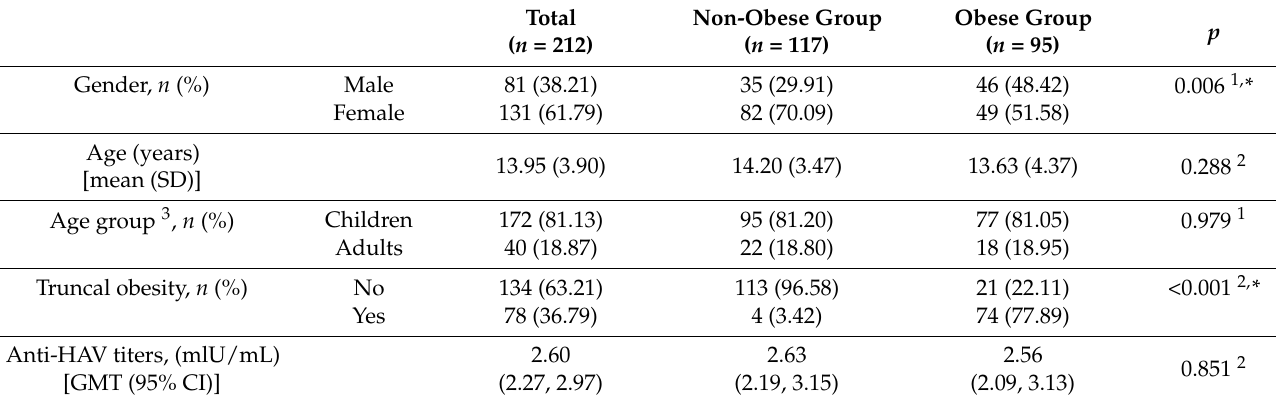
Table 1. Baseline characteristics by nutritional status